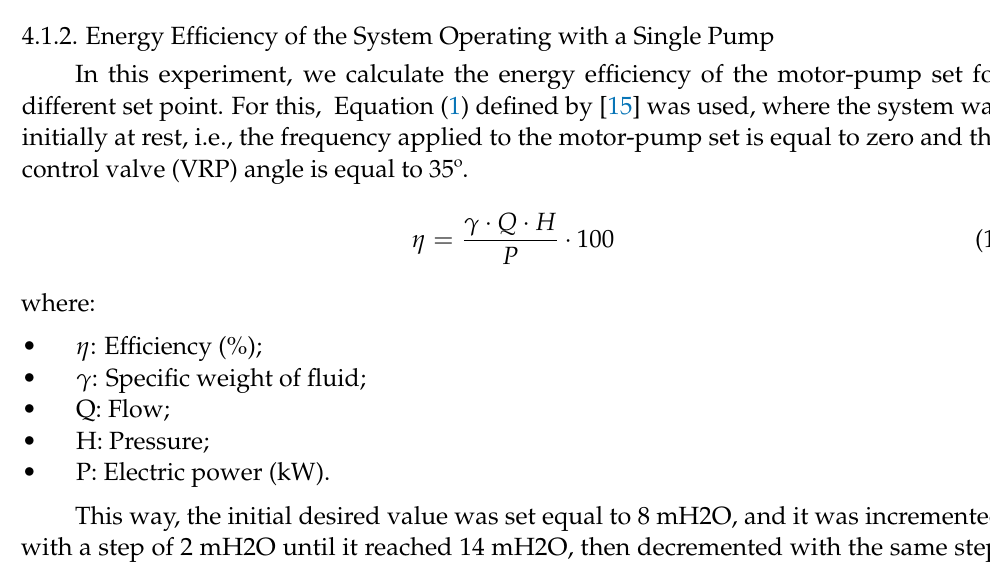
Steady State Settlement Overshoot Time